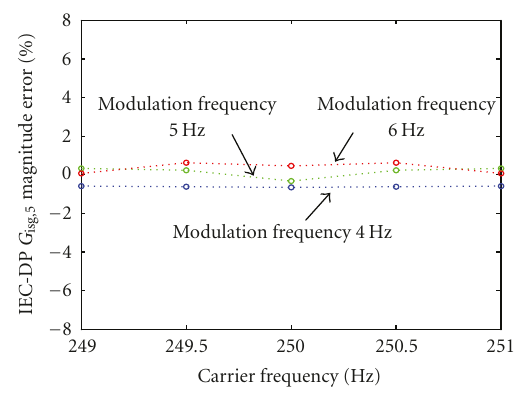
Figure 13: Case study 4: harmonic subgroup G sg,5 magnitude error (in %) versus interharmonic frequency, smoothing the results over 15 intervals of 200 milliseconds for the IEC-DP (dotted line ◦ ).